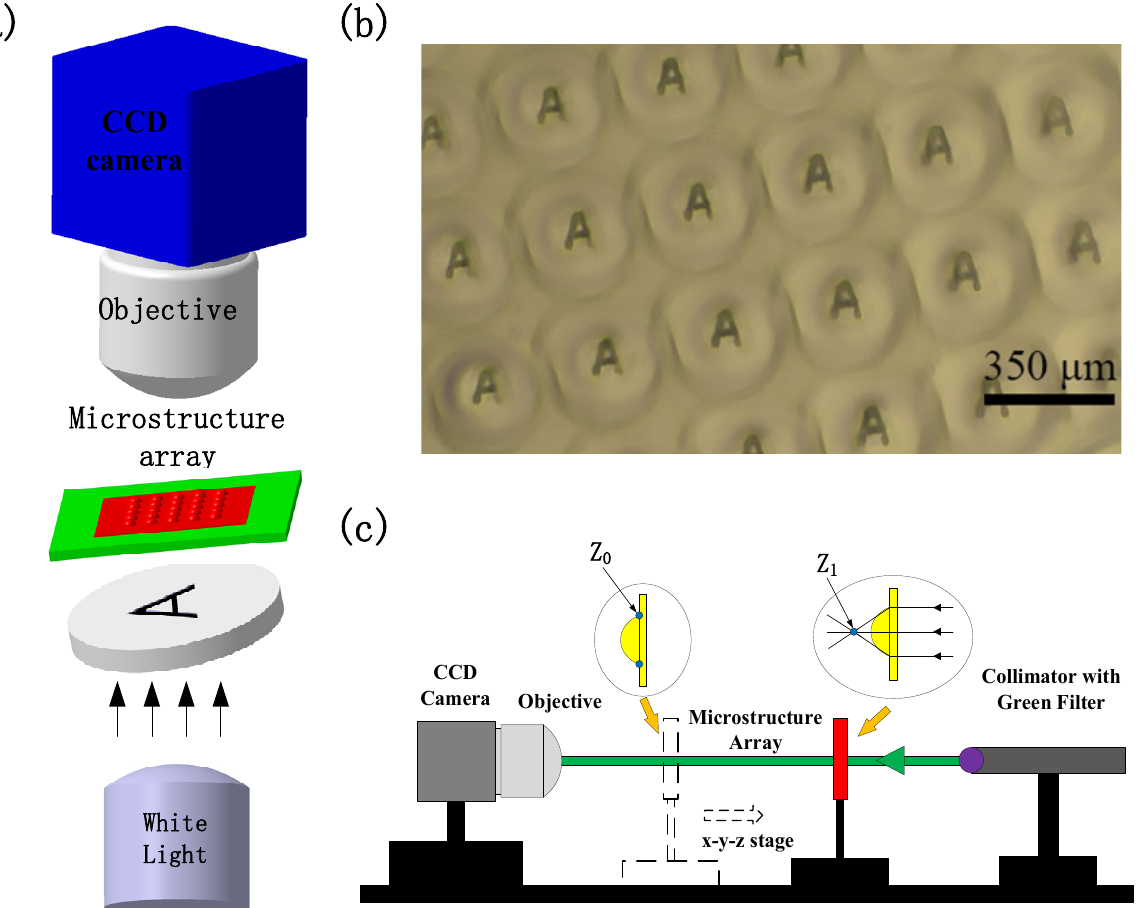
Figure 4. ( a ) Optical setup for demonstrating the lensing properties of the fabricated film microstructure array; ( b ) Optical microscope image of the multiple images of alphabet “A” through the fabricated film microstructure array; ( c ) The experimental setup for measuring the focal length of the curved film microstructure.